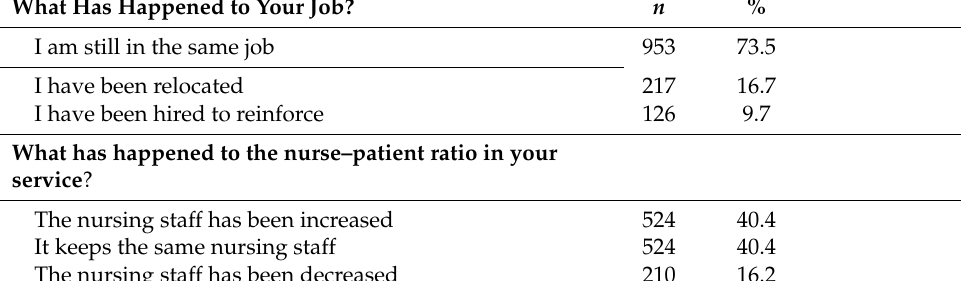
Table 2. Organizational changes in job position or role as a nurse: redeployment ( n = 1296). What Has Happened to Your